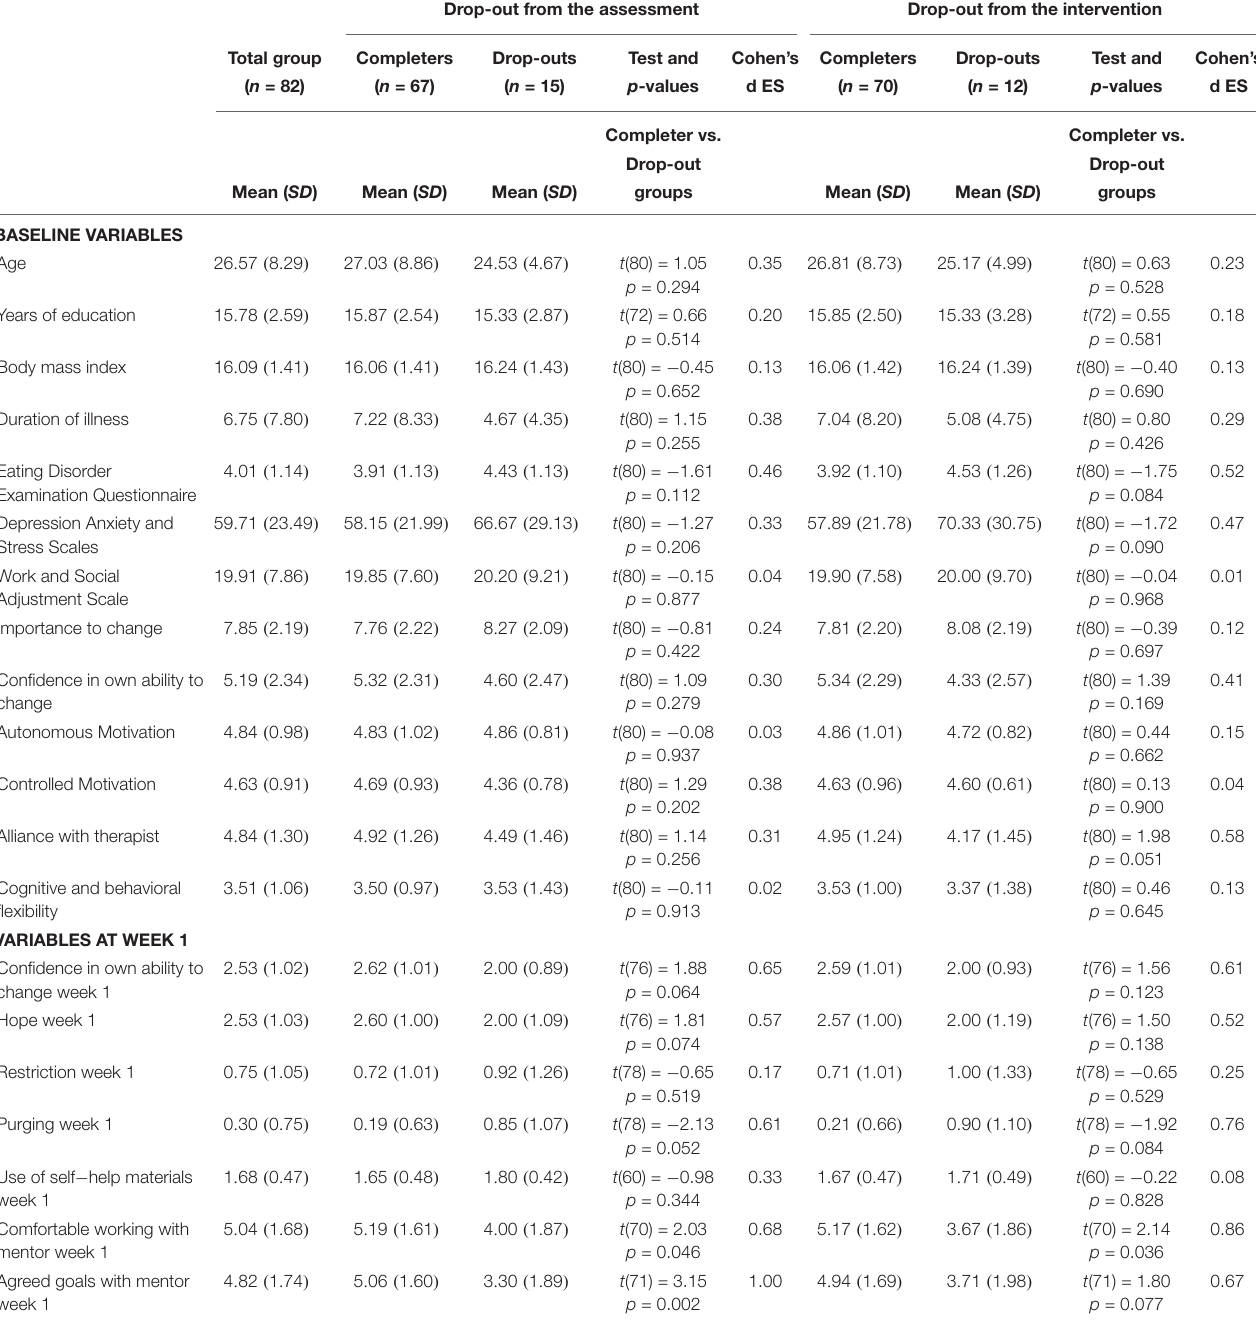
TABLE 1 | Participants’ demographics and clinical